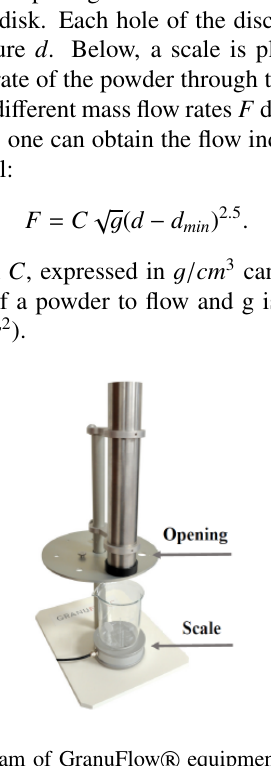
Figure 2. Left: Sketch of GranuCharge used to measure the elec- trostatic charge created inside a powder after flow in contact with a selected material. Right: Picture of the powder flowing from the tube 2 into the Faraday cup measuring the electrostatic charge